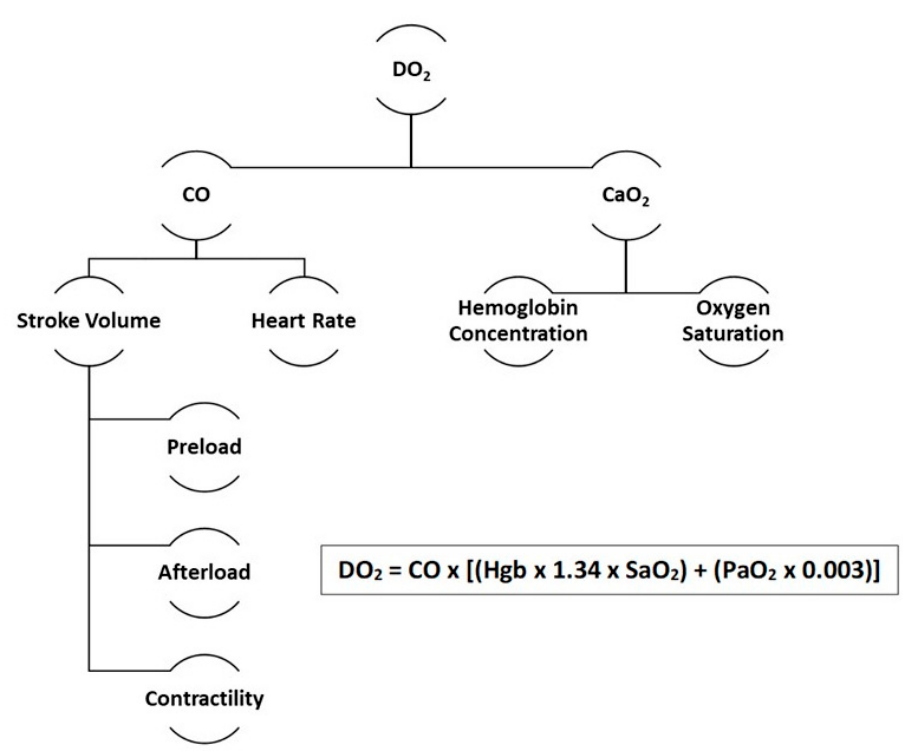
Figure 1. Determinants of oxygen delivery (DO 2 ). CO–Cardiac output; CaO 2 –Oxygen content; Hgb–Hemoglobin concentration; SaO 2 –Oxygen saturation; PaO 2 –Partial pressure of oxygen.